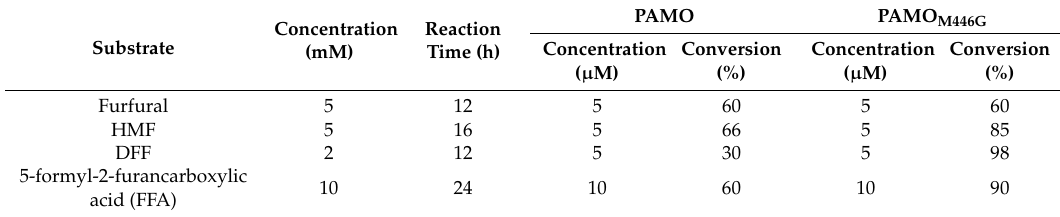
Table 2. HPLC analysis of conversion of furans by PAMO and PAMO M446G